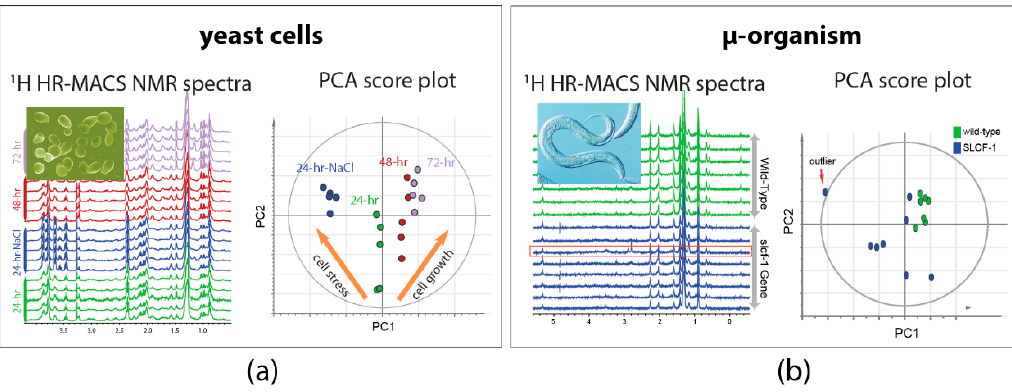
Figure 3. 1 H HR-MACS NMR spectral comparison and the principal component analysis (PCA) of ( a ) different yeast cells groups and ( b ) different strains of C. Elegans . Each one of the score plot corresponding to a PCA displays the quality data validated by the explained variation (R 2 X) and the predicted variation of the models (Q 2 ). In (a) the PCA (with R 2 X(sum) = 0.793 and Q 2 (cum) = 0.737) clearly discriminates the different cell conditions (stress and growth). Adapted with permission from [25]. Copyright (2014) Frontiers in Chemistry. In (b) the PCA (with R 2 X(sum) = 0.964 and Q 2 (cum) = 0.8) confirms the reliability of the discrimination between the wild-type C. Elegans (green) and the strain of slcf-1 mutant (blue) with only 12 individuals. Adapted with permission from [26]. Copyright American Chemical Society.